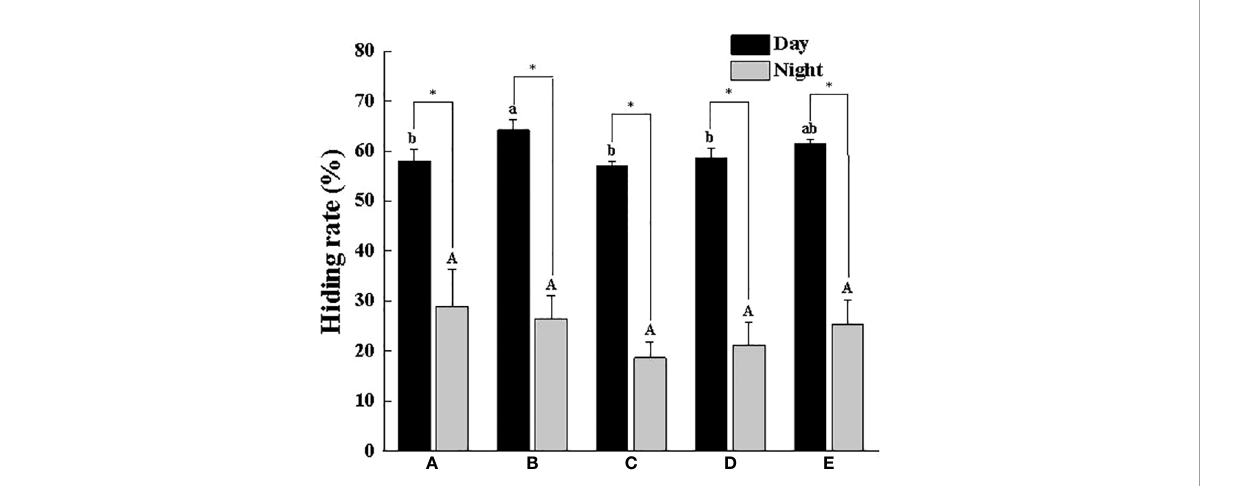
FIGURE 3 Hidden rate of swimming crab with different body weight groups in the presence of shelters. Different letters indicate signi fi cant differences among different body weight groups ( P < 0.05) and “ * ” indicates signi fi cant differences between day and night ( P < 0.05).